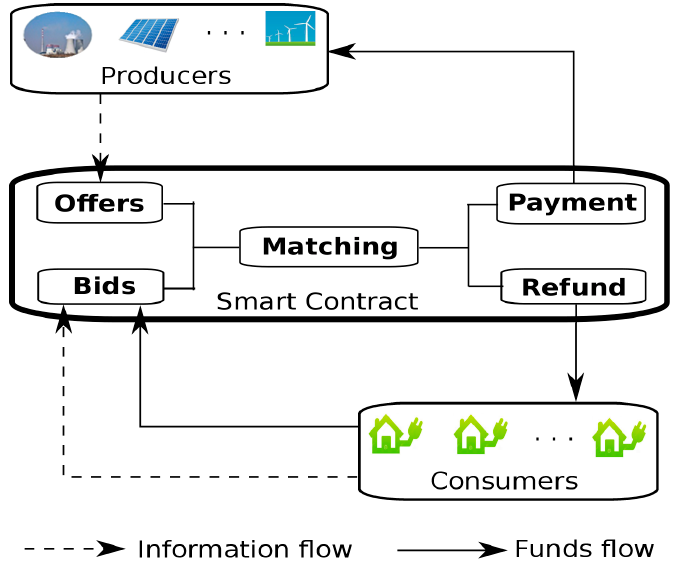
Figure 1. Smart contract-based P2P energy trading scheme.